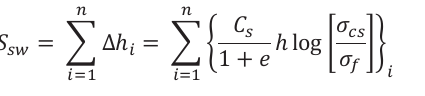
Table 2: Soils parameters used in the numerical study